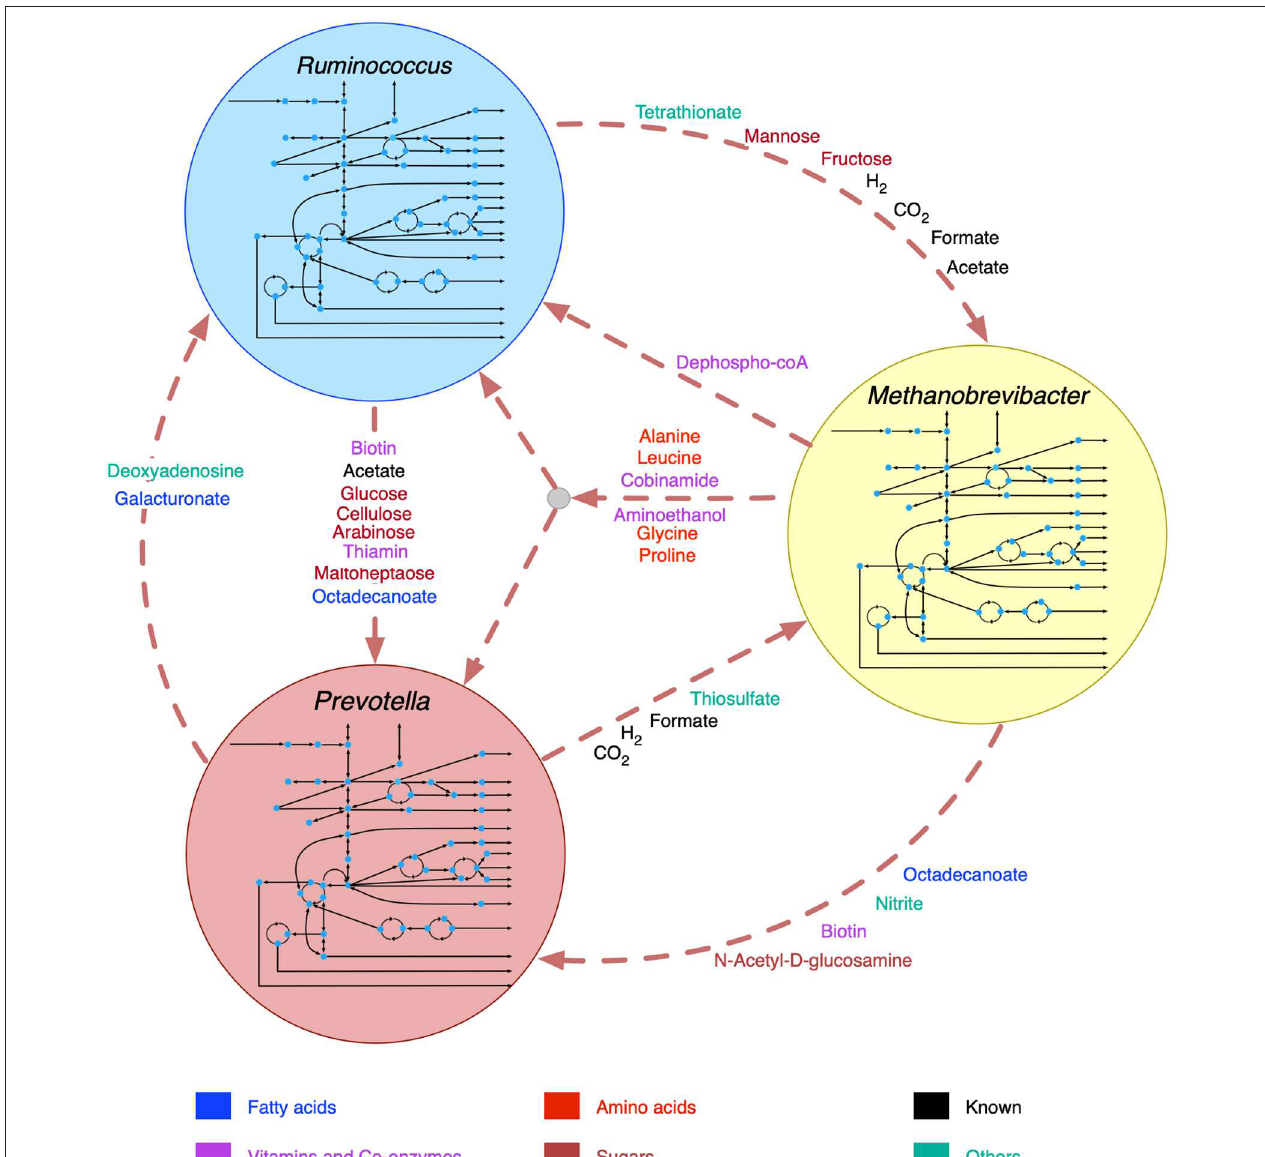
FIGURE 2 | Identified de novo interactions in the community. Metabolites in black text were previously known to be exchanged, metabolites in color text are identified in this work. A cartoon inside the circles shows the main pathway map for each